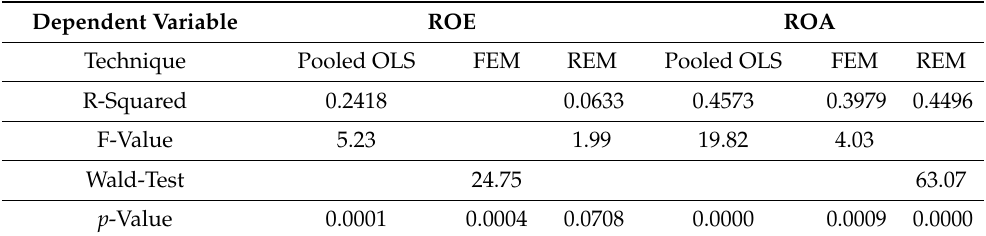
Table 3. Regression